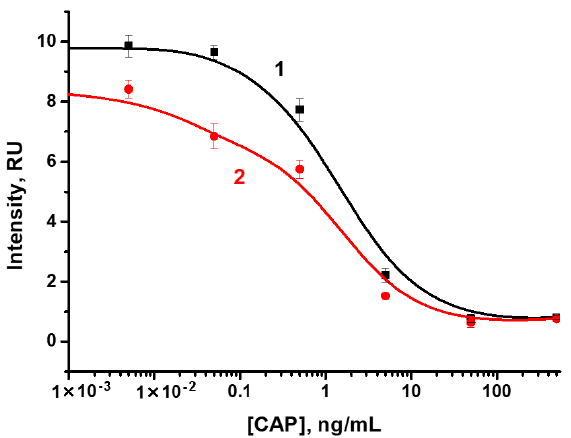
Figure 6. LFIA of CAP in honey by ( a ) standard competitive scheme and ( b ) double competitive scheme. The appearance of test strips after the assays.